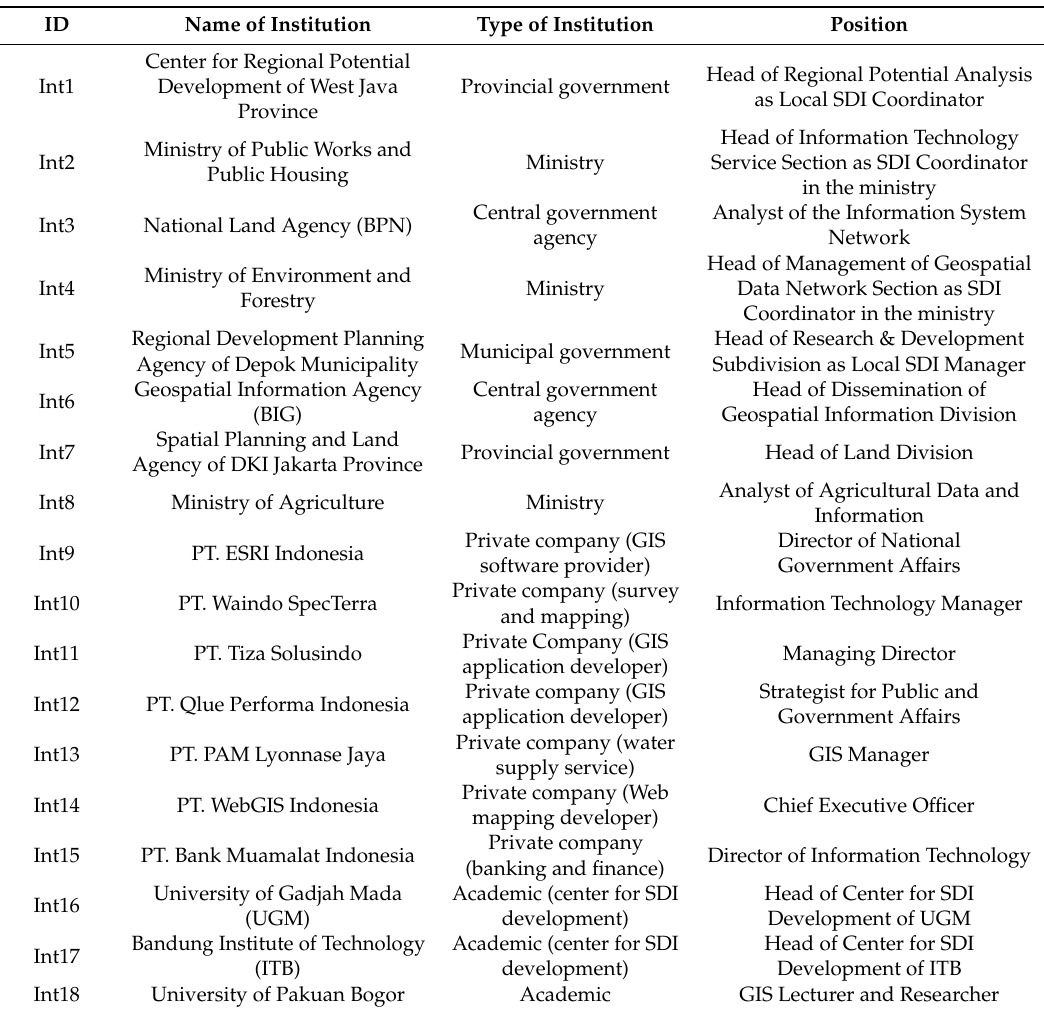
Table A1. Details of the interviewees’ institutions and